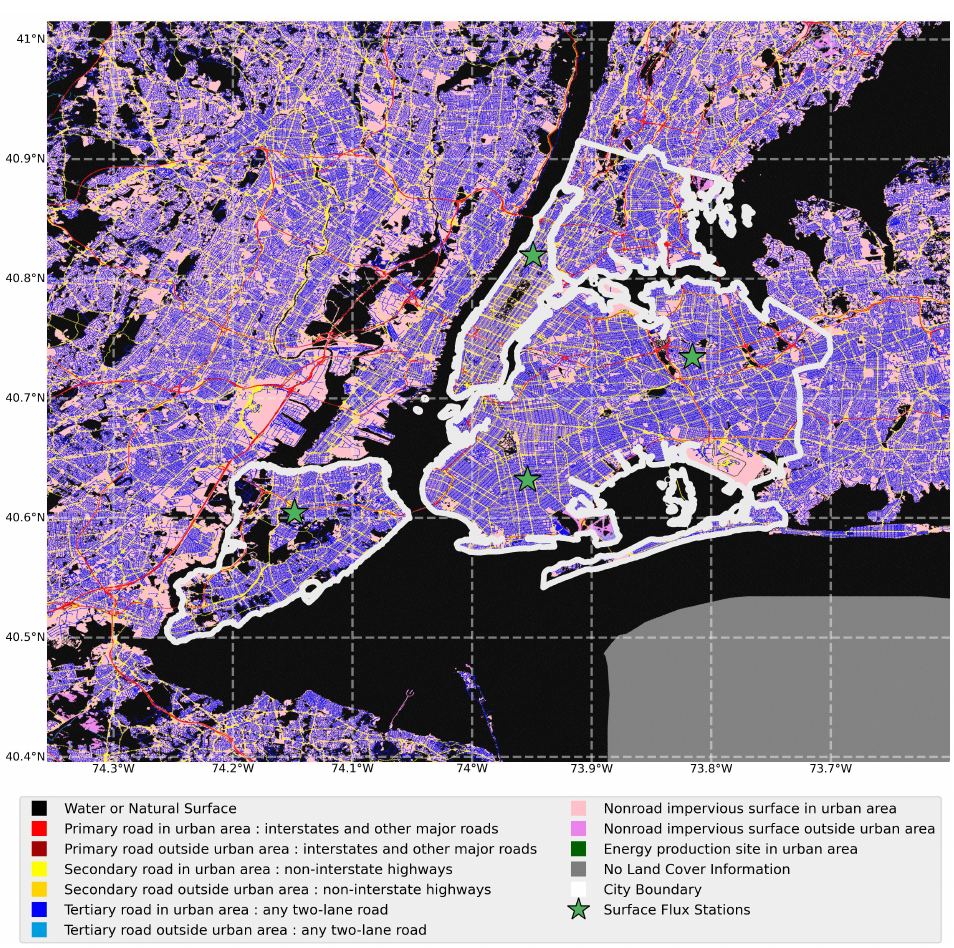
Figure 1. Imperviousness land cover from NLCD 2016 showing the boundary used in the case study of New York